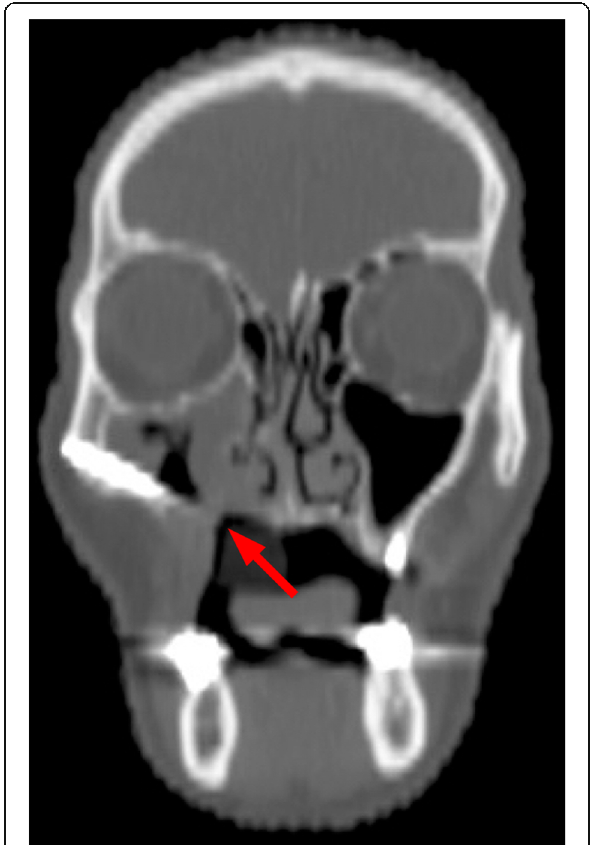
Fig. 16 Pt no. 3. CT scan showing the optimal ZI insertion and the newly formed oroantral